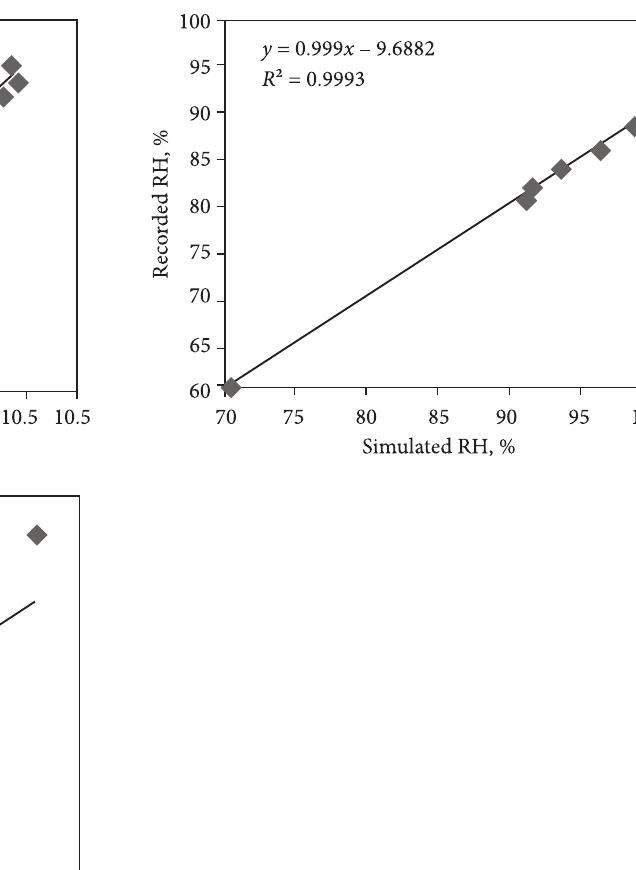
Figure 3. Simulated versus recorded values of mean air temperature, relative humidity and wind velocity of the current park in the period time from